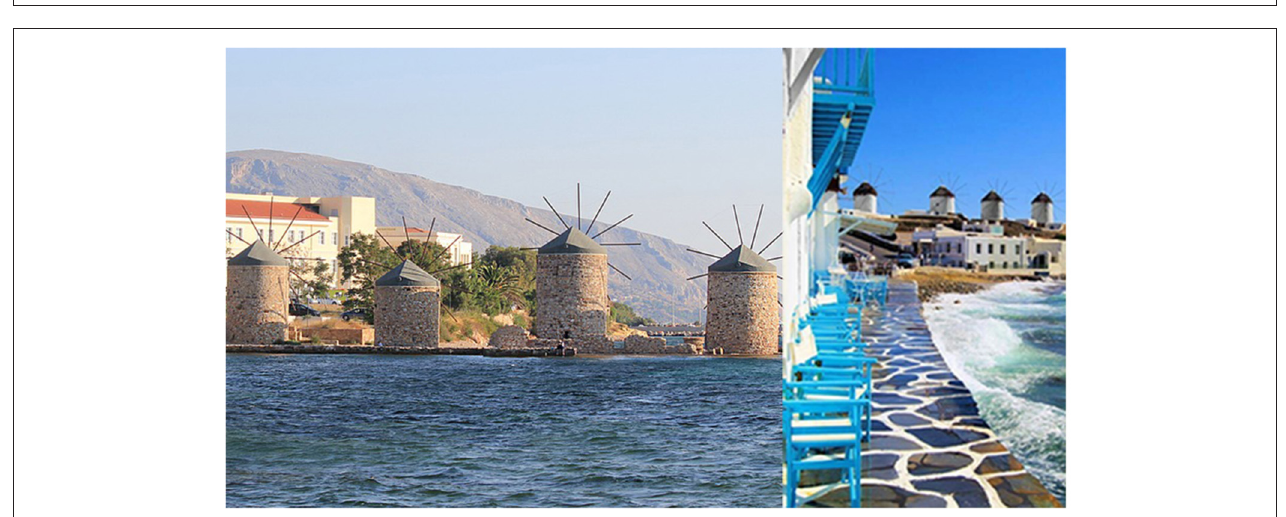
FIGURE 8 | Mass concentration of chlorophyll in sea water (www.waters-creative.co.uk, 2015).